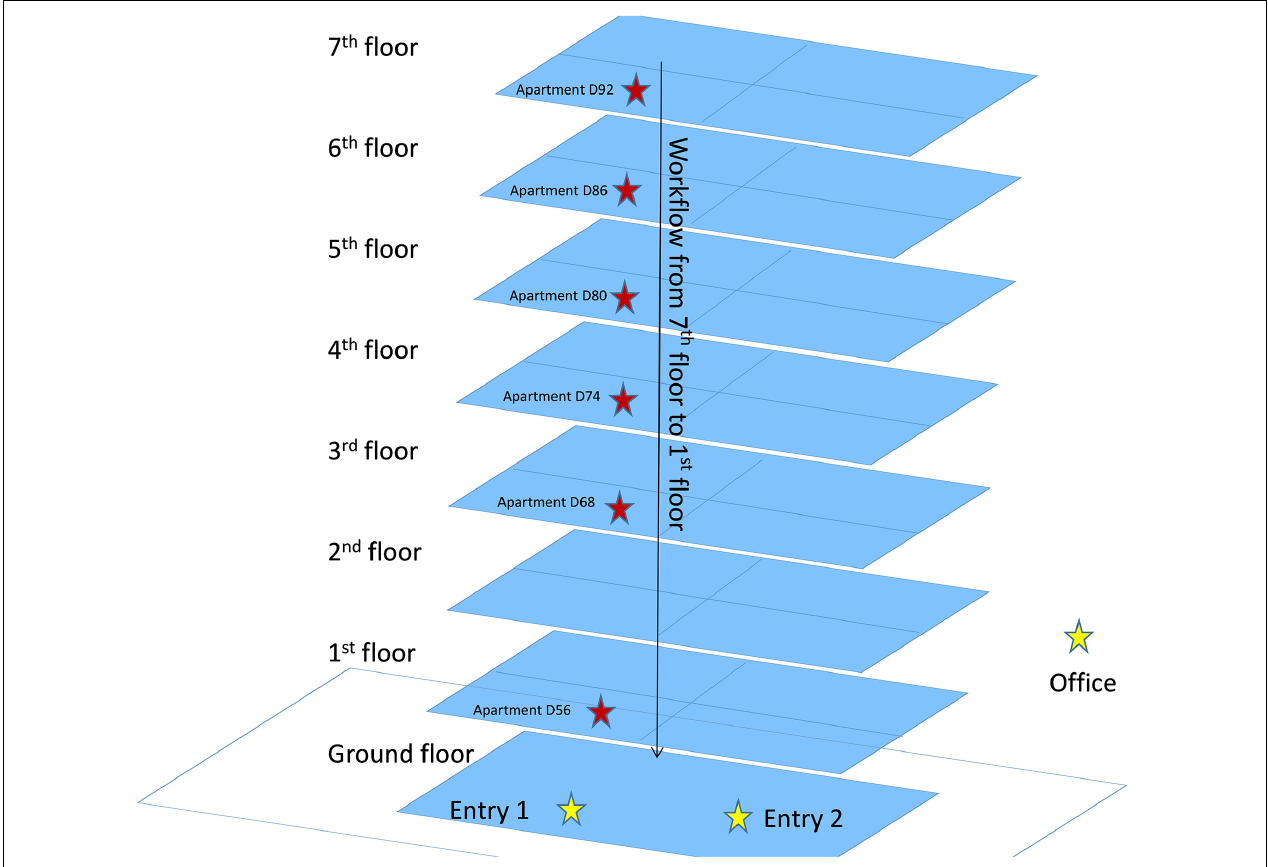
FIGURE 2 | Floor plan of the selected case study, with gateways marked.